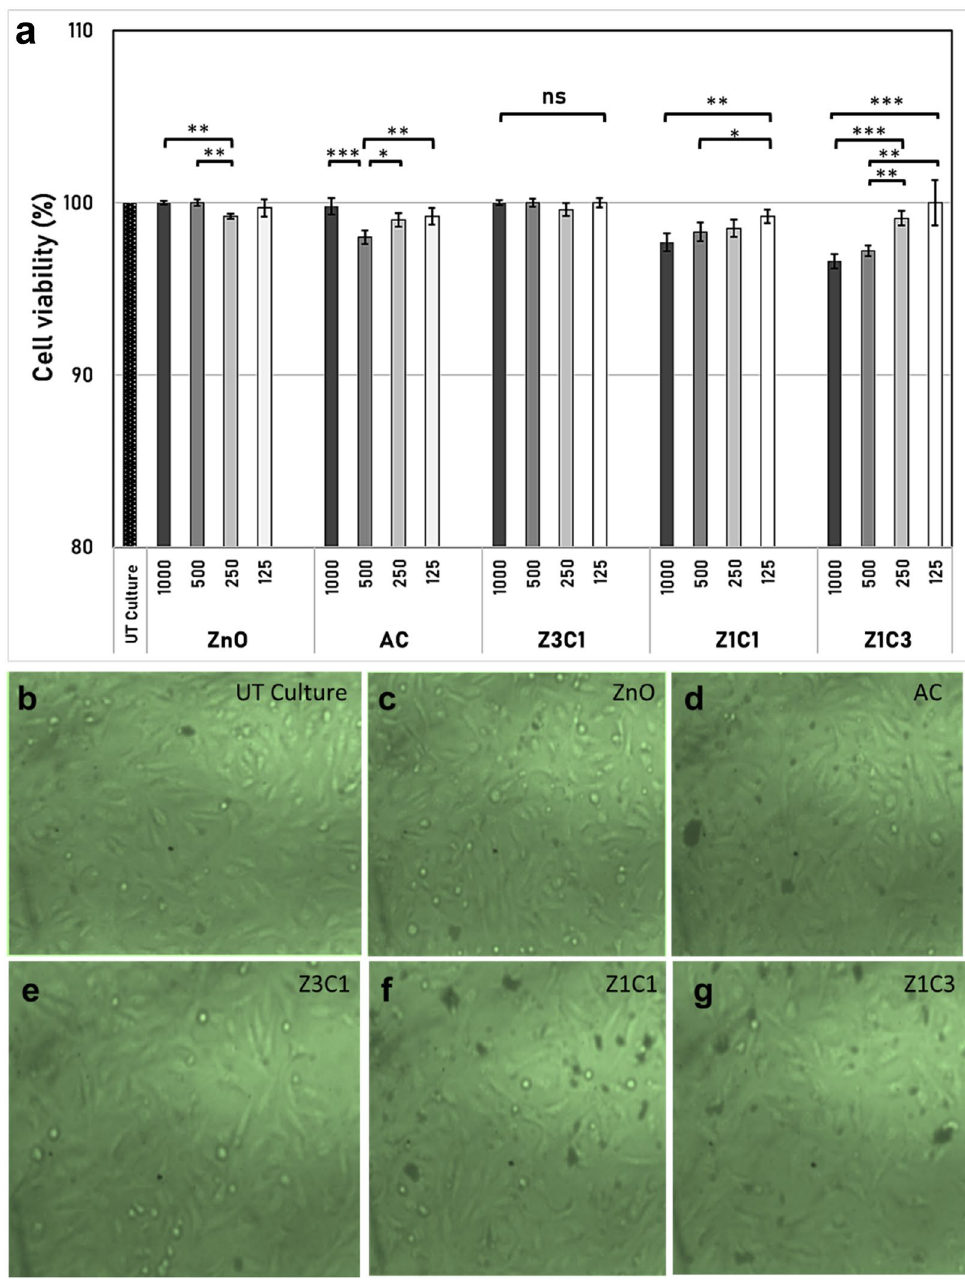
Figure 2. Cytotoxicity of multi concentrations of the synthesized ZnO NPs/AC nanocomposites (µg/mL) on the WI38 human cell line compared to the untreated (UT culture) cell line. The error bars are the estimated standard deviations (n = 3). The (ns) refers to a non-significant difference, where p > 0.05. * p < 0.05, ** p < 0.01, and *** p < 0.001; ( b ) the microscopic image of the untreated WI38 cell line; ( c – g ) cell lines treated with the ZnO NPs/AC composites (1000